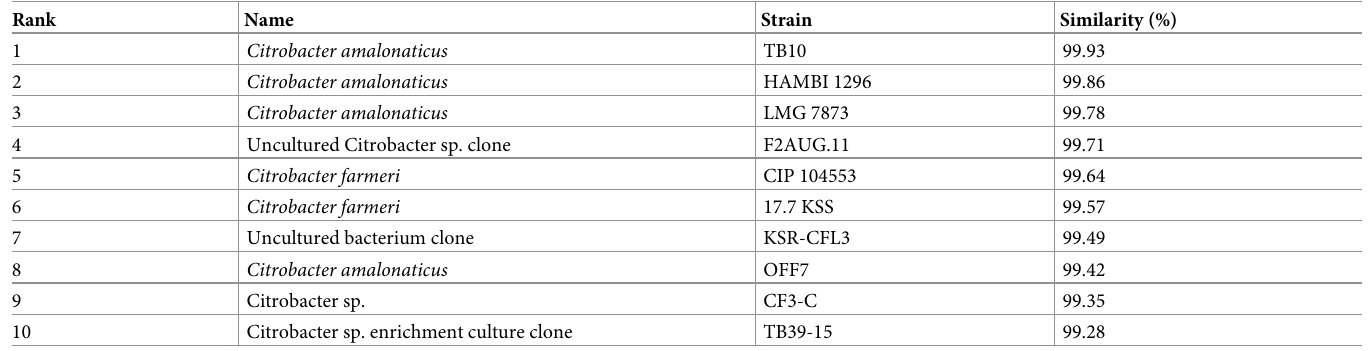
Table 2. Sequence homology